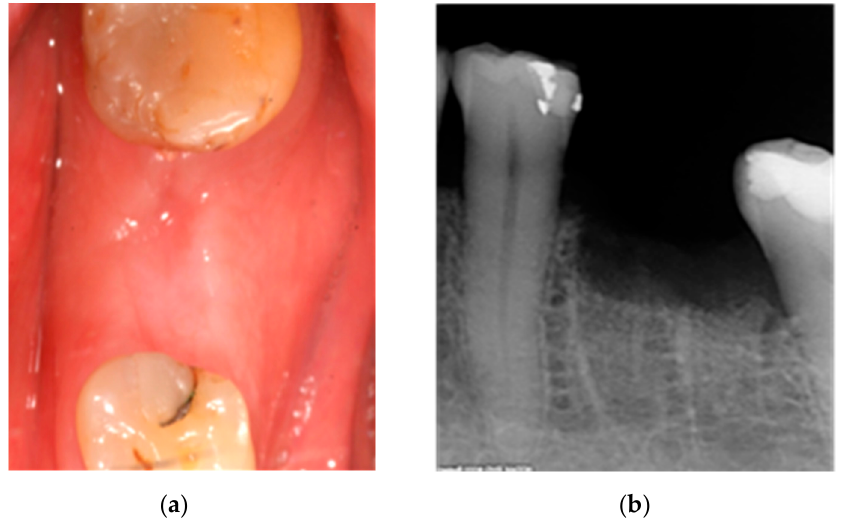
Figure 2. ( a ) Clinical aspect and ( b ) X-ray of the affected area 12 months after